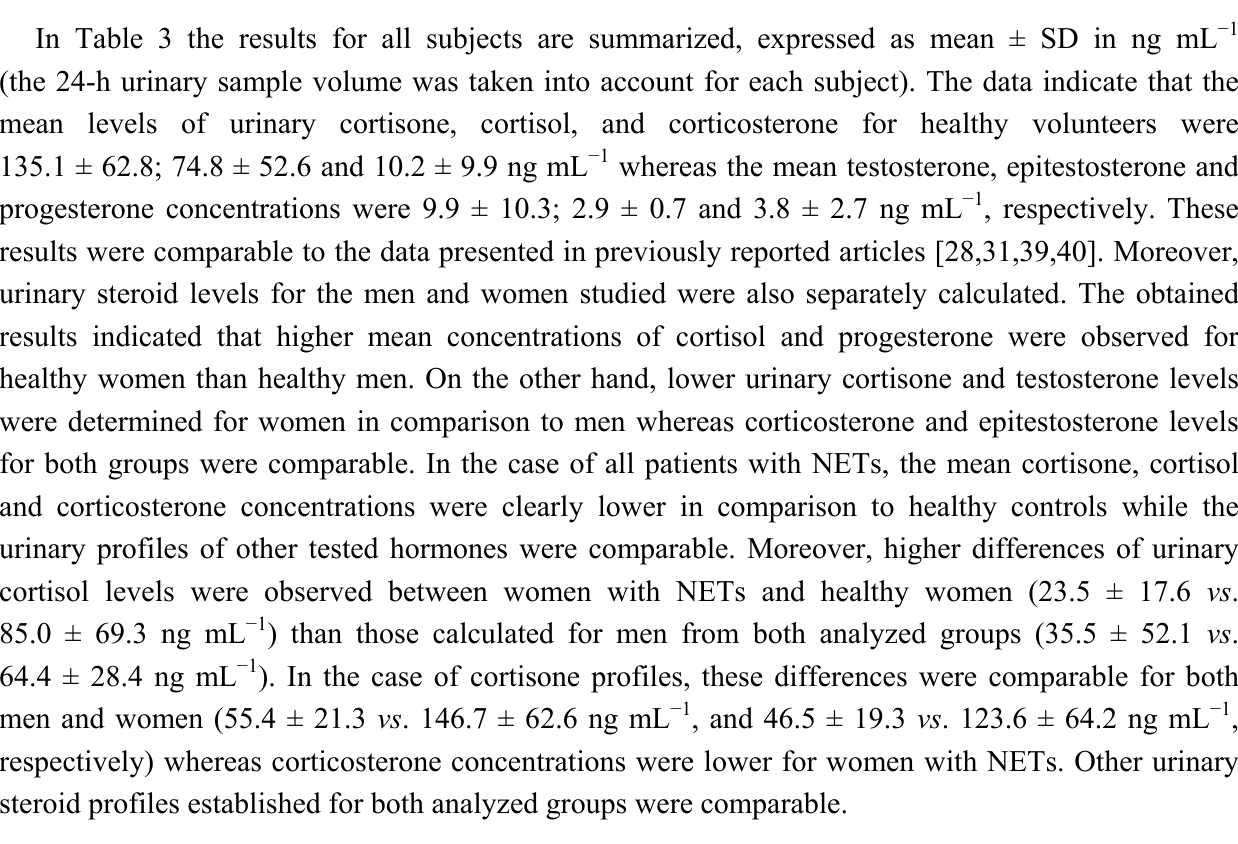
Table 3. The results of six urinary free steroid levels measured by the LC-UV method in healthy controls against patients with